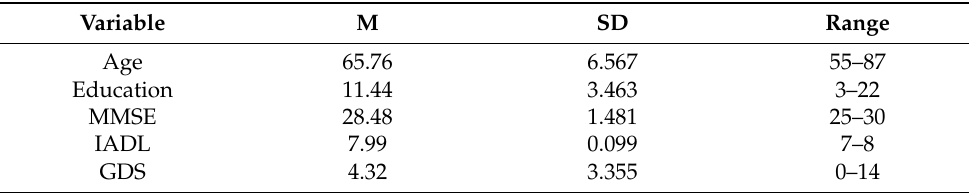
Table 1. Demographic statistics and performance on MMSE, IADL, and GDS.